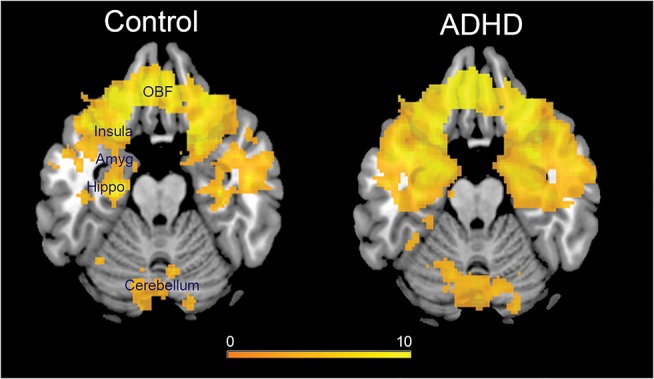
Affective networks in healthy control and ADHD groups identified using independent component analysis (ICA).Resting-state data from all the subjects (healthy control children and children with ADHD) were aggregated into group-level ICA. The combined affective network across all the subjects was identified by visual spatial template matching with a previously identified affective/limbic network of 1000 subjects [41]. Individual maps of the affective network were then constructed by back-projection. The group-level average affective network for healthy control children and ADHD children are presented here at p<0.05 FWE corrected. Color bar represents t-statistics.